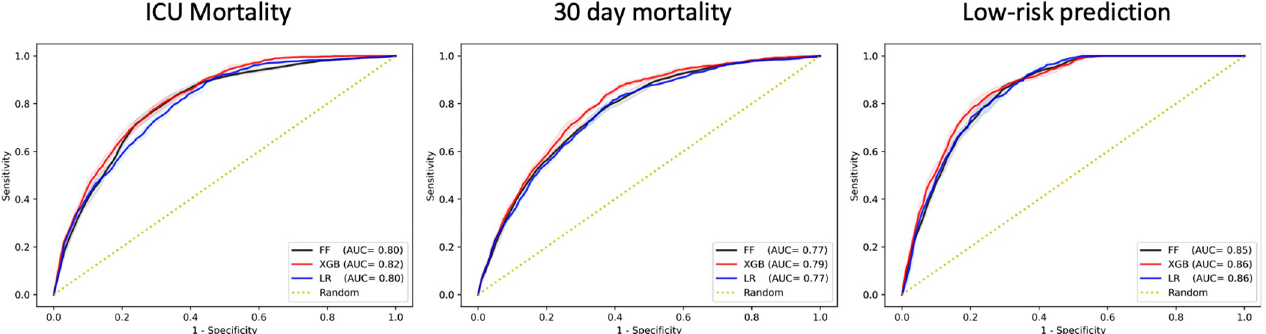
Fig 5. AUC performance of each model in validation on patients admitted in ICUs in France as the country with the highest number of ICU admissions for each of the three outcomes. AUC and AUPRC performance graphs of each model in internal cross-validation are available in Fig A in S3 Text.